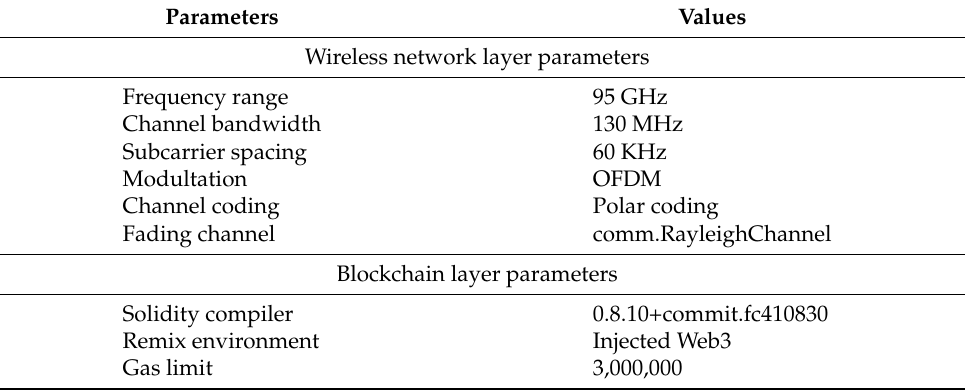
Table 4. Simulation parameters of the proposed